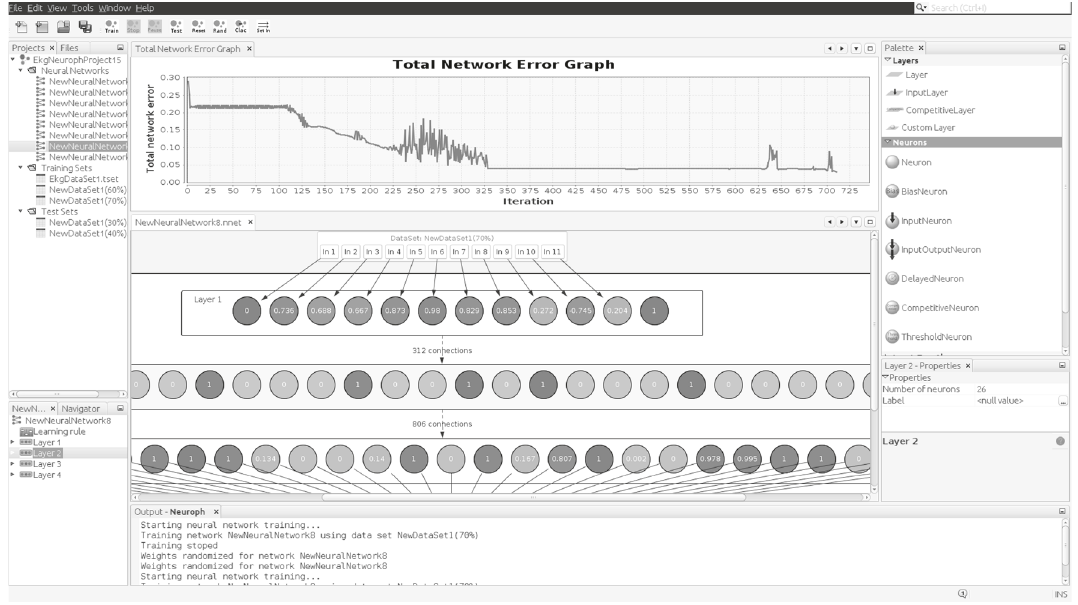
Figure 1: Neuroph software used for neural network training.